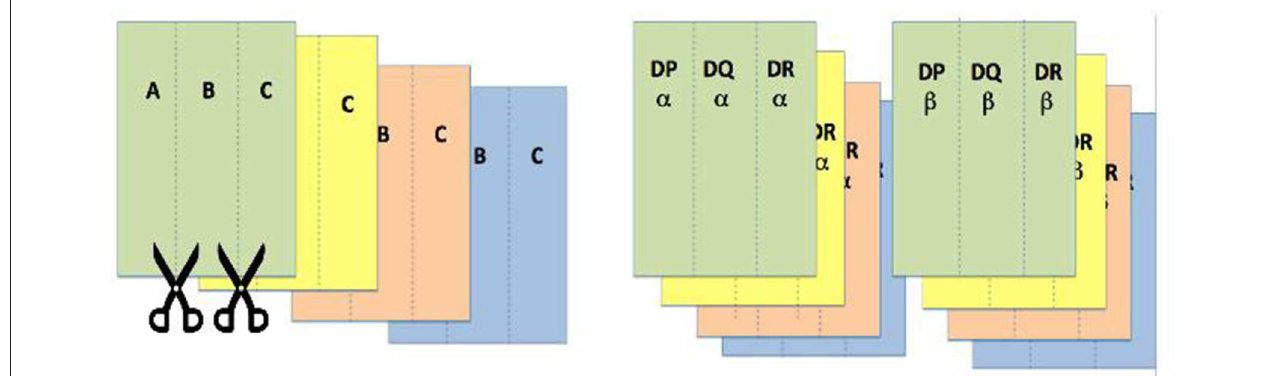
FIGURE 1 | MHC Diversity Activity. Examples of the paper cut outs used to generate a “gene bank” for the MHC diversity activity. We usually make many copies of the same gene in the same color to represent common alleles, and one or a few unique colors for each gene to demonstrate rare